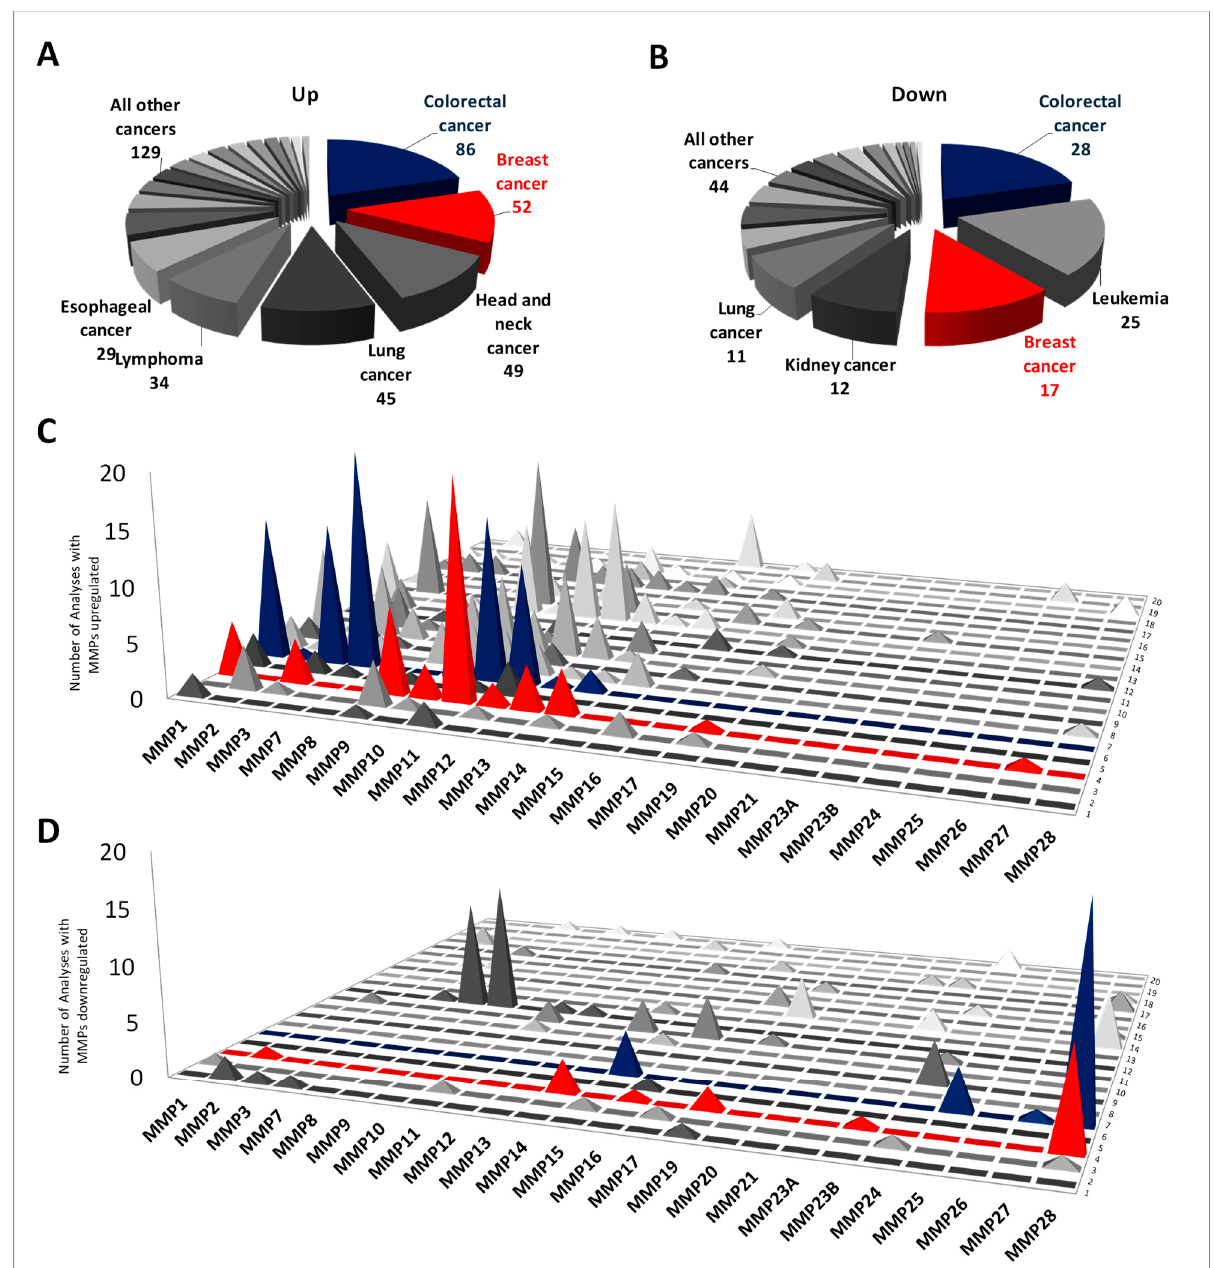
Figure 1. Differential expression of MMP members between normal and cancer tissues in different cancer types using Oncomine. ( A – C ) Pie charts showing the number of analyses in which the MMP members were found to be significantly deregulated (upregulated or downregulated) in cancer compared to normal tissues. ( B – D ) Histograms showing the number of analyses in which the MMPs were found to be significantly deregulated, sorted for individual MMPs and cancer type.